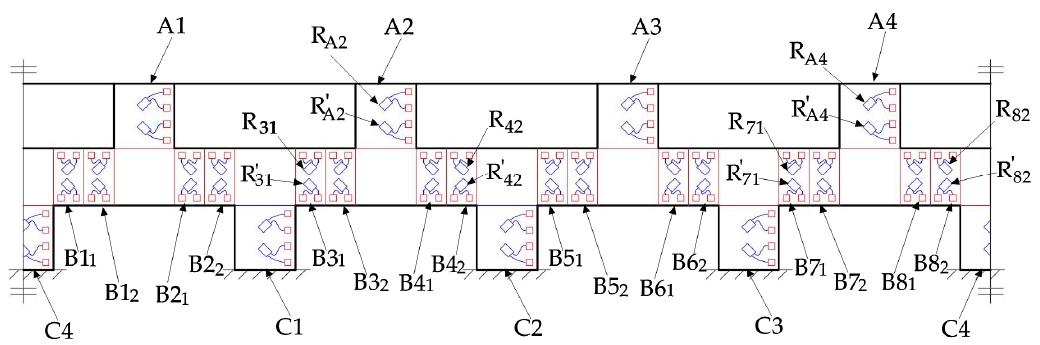
Figure 17. Distribution of strain gauges pasted on the cylinder-shaped elastic structural body. After the pasting of the strain gauges, the strain gauges pasted in di ff erent areas are connected to form six electric bridges. The four strain gauges pasted in A2 and A4 are connected to form the 1st electric bridge to measure the strain caused by the force F X . The strain gauges pasted in A1 and A3 are connected to form the 2nd electric bridge to measure the strain caused by the force F Y . The strain gauges pasted in B1 2 , B2 1 , B3 2 , B4 1 , B5 2 , B6 1 , B7 2 , and B8 1 are connected to form the third electric bridge to measure the strain induced by the force F Z . Similarly, the strain caused by the moment M X can be measured by the fourth electric bridge made up of strain gauges stuck in B3 1 , B4 2 , B7 1 , and B8 2 , the indirect measurement of the moment M Y is obtainable by the fifth electric bridge made up of strain gauges pasted in B1 1 , B2 2 , B5 1 , and B6 2 , the strain caused by the moment M Z can be measured by the sixth electric bridge made up of strain gauges pasted in C1 , C2 , C3 , and C4 . As presented in Sections 3.2 and 3.3, this paper utilizes the sum or the di ff erence of strain values of the points in the outside surface of the ESB to measure the traction force. The sum of strain values of the points in the outside surface of A2 and A4 respectively is used to represent the force F X . Therefore, the connection mode of the four strain gauges pasted in A2 and A4 is shown in Figure 18a. ∆ R F X and ∆ R M represent the changes in the resistance values of the strain gauges caused by the force Z F X and the moment M Z respectively. In addition, the minus sign and plus sign of ∆ R F and ∆ R M X Z indicate that the strain gauge is compressed and stretched respectively. According to the measurement principle of electric bridges, when ∆ R F is zero, the output voltage is zero even if ∆ R M is not equal X X to zero. However, the output voltage is not zero when ∆ R M is equal to zero and ∆ R F is not zero. X X Therefore, the 1st electric bridge can measure the force F X . In order to measure the forces F Y and F Z , the connection mode of the second and the third electric bridges is basically the same as that of the 1st electric